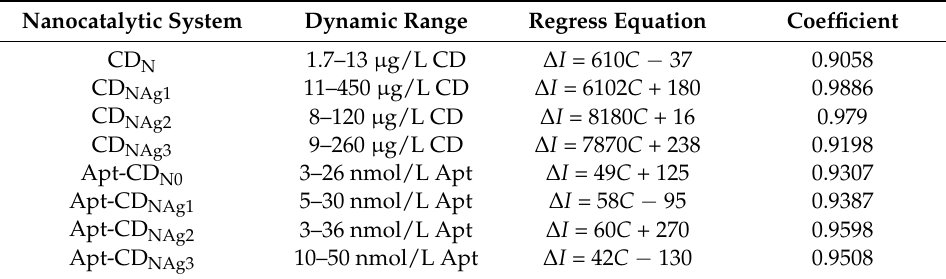
Table 1. Nanocatalysis and Apt